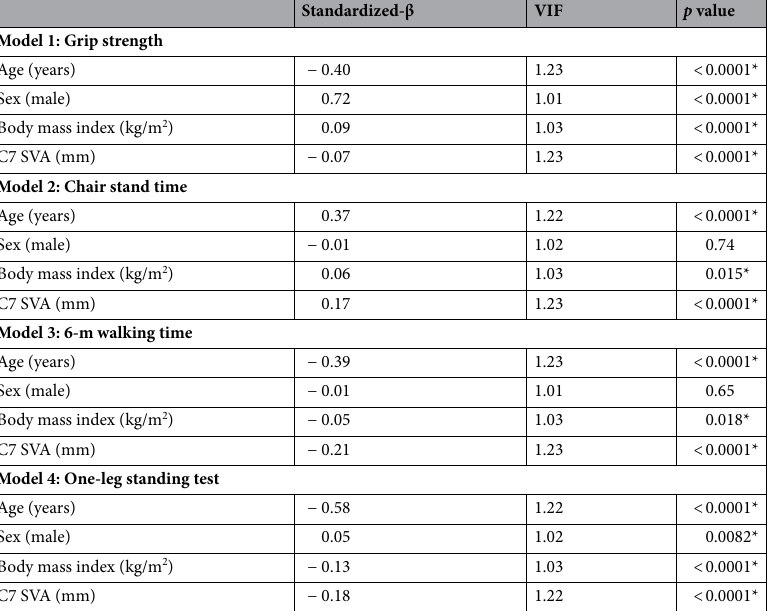
Table 4. Association of physical performance (grip strength, chair-stand time, 6-m walking time, and one leg standing test) with C7 SVA. Beta values are shown using multiple regression analysis after adjustment for age, sex, and body mass index. Multiple regression analysis, with measurements of each physical performance (grip strength, 6-m walking time, chair stand time, or one-leg standing test) as objective variables (from Model 1 to Model 4), was performed to estimate the association of physical performance with C7 SVA after adjustment for age, sex, and body mass index. CI, confidence interval; VIF, variance inflation factor; C7 SVA, sagittal vertical axis at